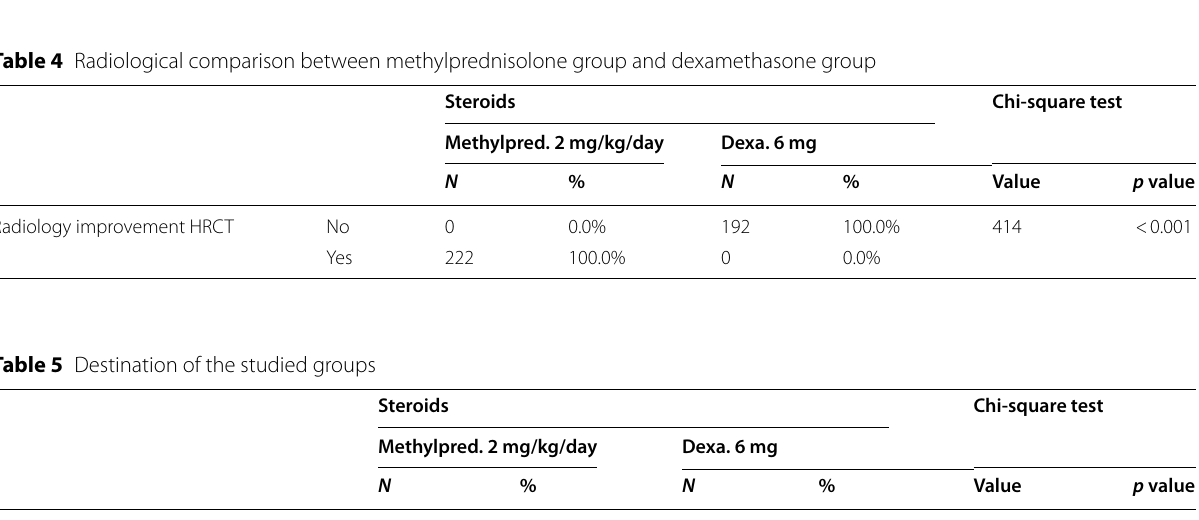
7.19 in the dexamethasone group ( p ±